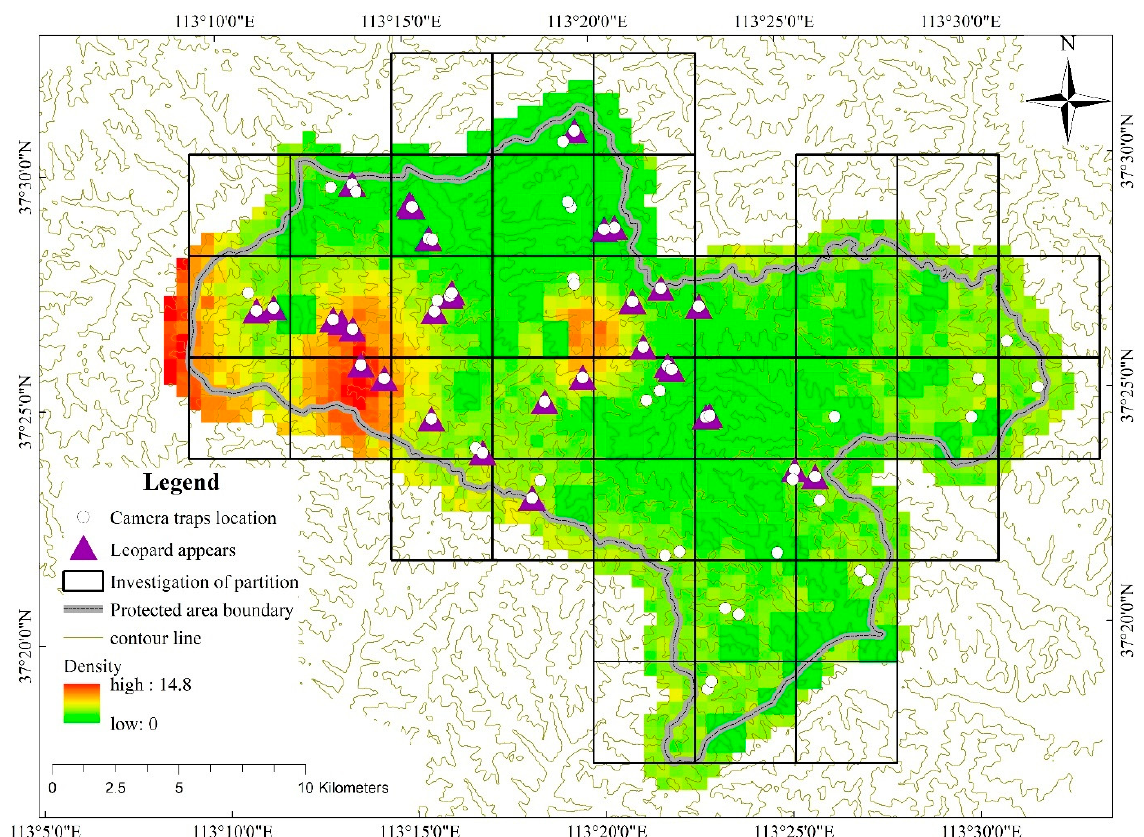
Figure 2. The spatial distribution of the North China leopard was predicated by the spatially explicit capture–recapture (SECR) model. The color gradient of each pixel represents the density gradient of North China leopard population at each pixel. Only pixels judged to be suitable habitat are included, and the size of each pixel is 0.25 km 2 .